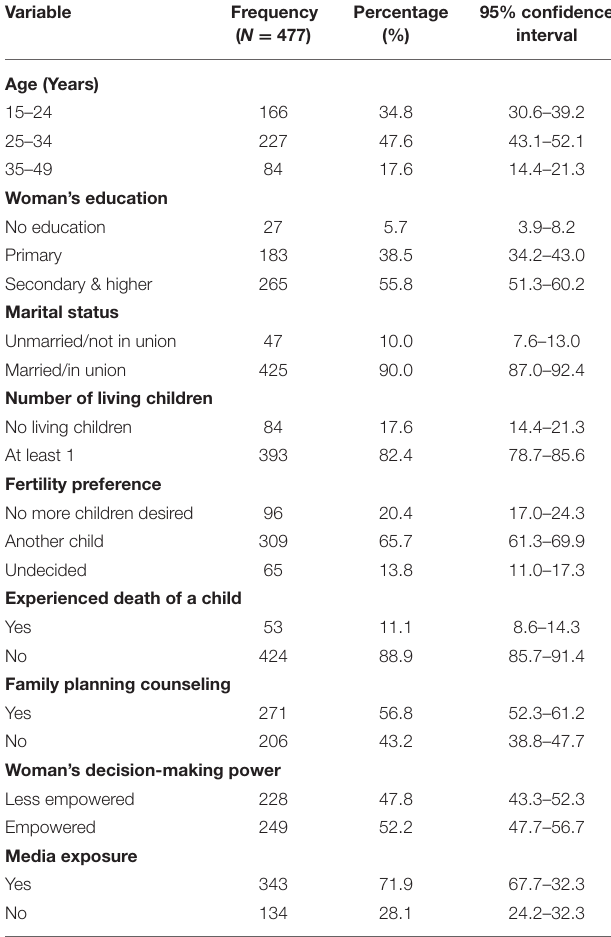
TABLE 1 | Background characteristics of the study participants. TABLE 2 | Prevalence of total demand, modern contraceptive use and unmet